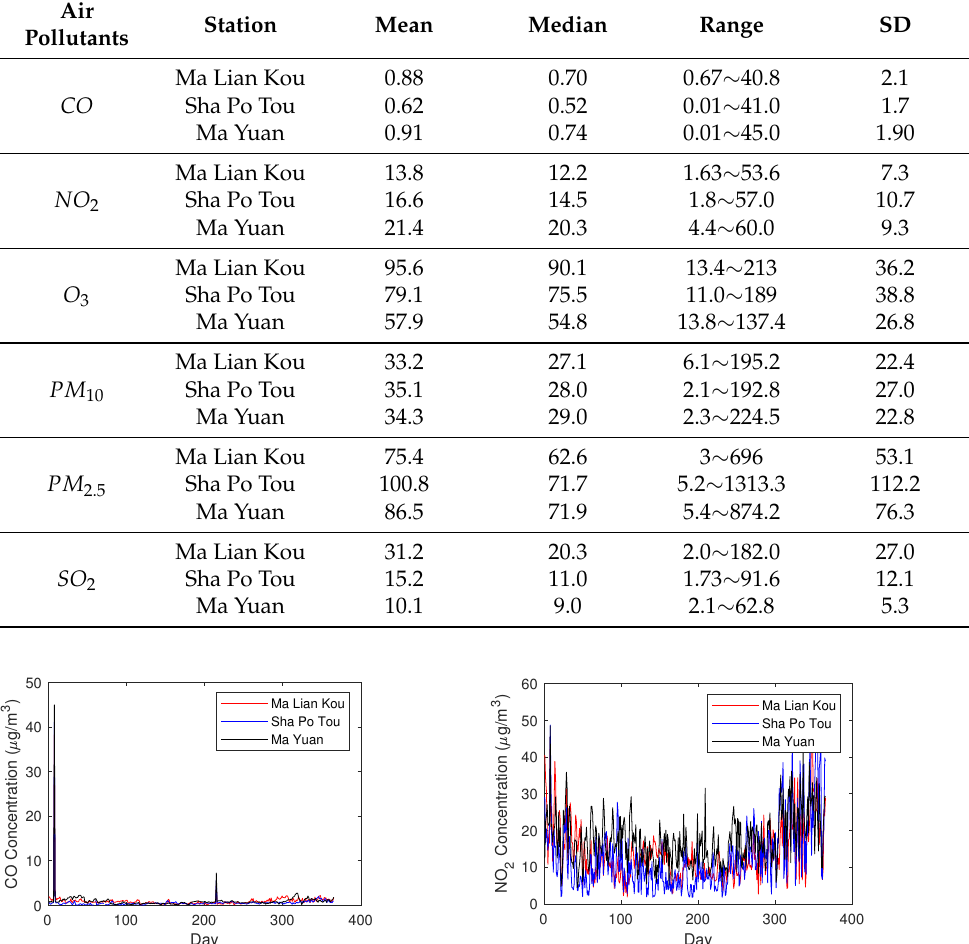
Figure 3. The variations of the concentrations for CO and NO 2 at Ma Lian Kou, Sha Po Tou and Ma Yuan in 2016.